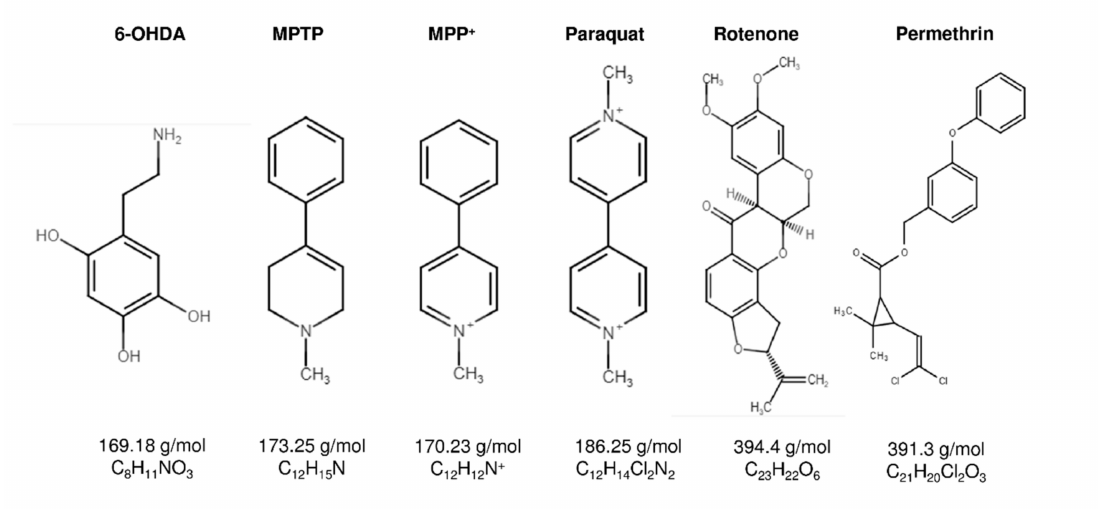
Figure 3. Chemical structures of neurotoxins used to induce Parkinsonism in animal